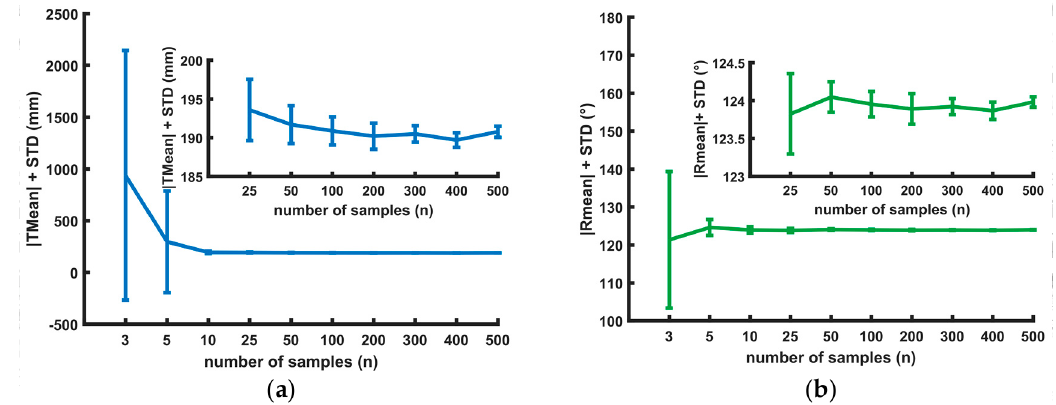
Figure 7. ( a ) Visualization of the amplitude of the translation (T mean ) and ( b ) amplitude of the rotation angle (R mean ) (axis-angle representation). Each test is repeated 50 times with n (random) sample points. The 68% confidence interval (2 times the standard deviation) is visualized with whiskers.